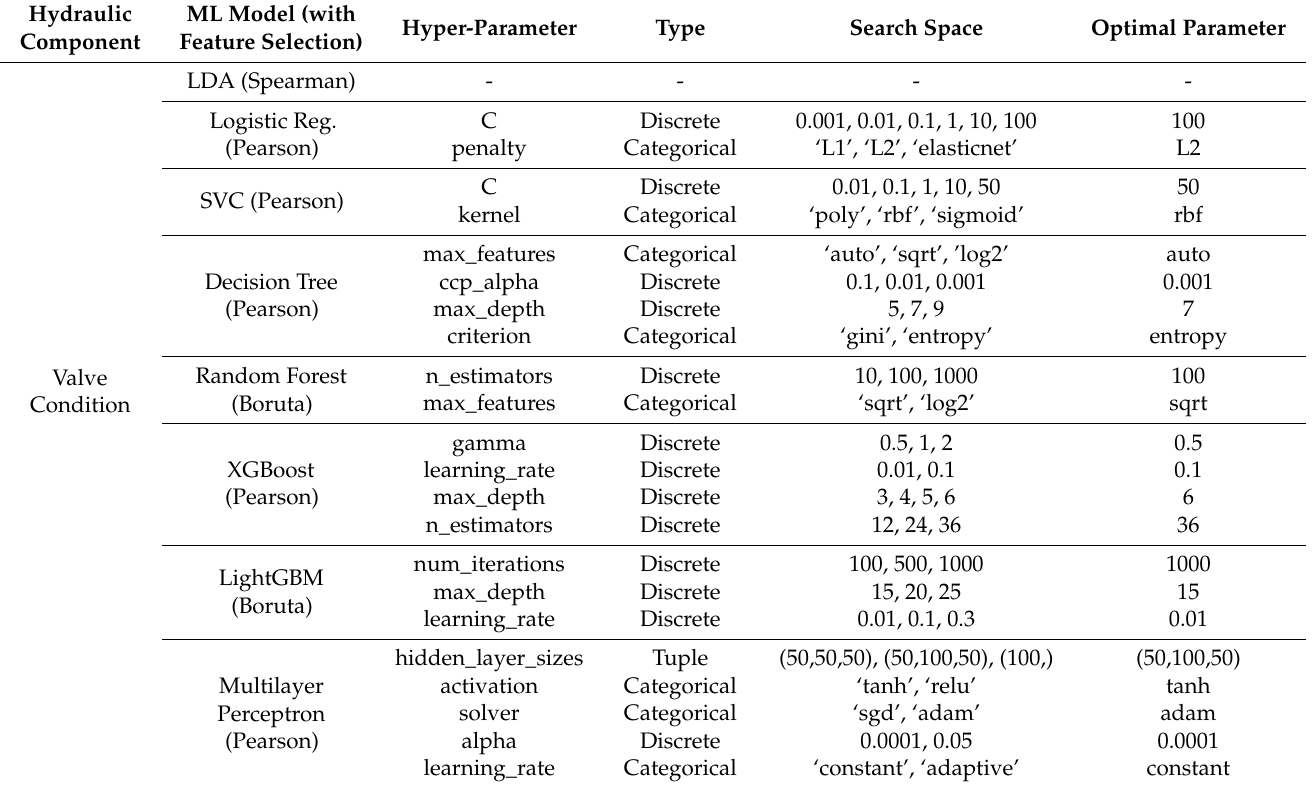
Table 7. Hyper-parameter configuration space and optimal parameter under valve